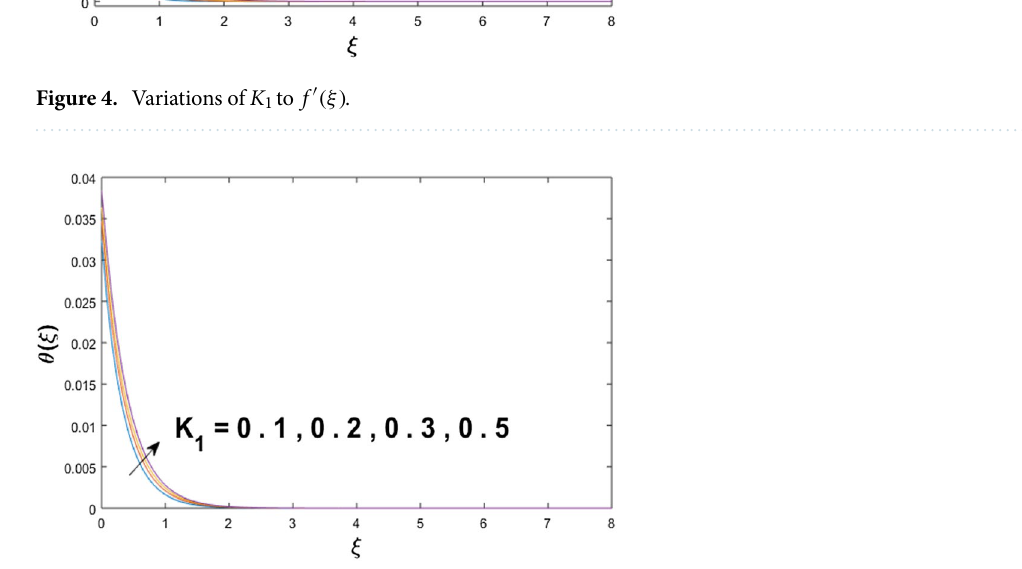
Figure 5. Variations of K 1 to θ(ξ)